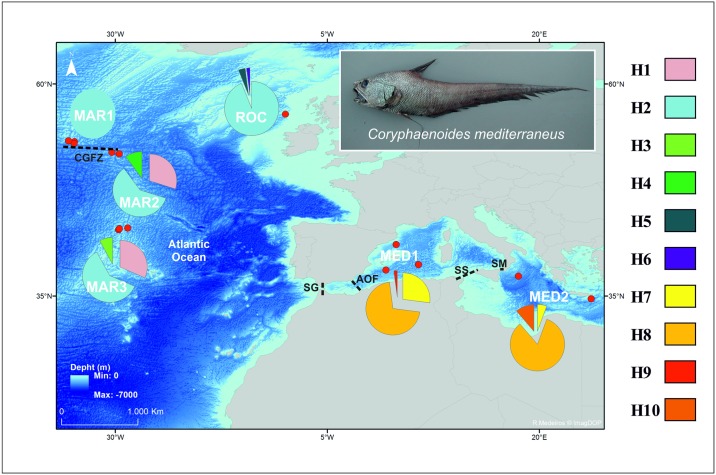
Map showing the sampling sites (red dots) of for Coryphaenoides mediterraneus.Pie charts report the haplotype distributions of the mtDNA COI, with the proportion of each haplotype within each collection site. Each haplotype is colour coded according to the legend on the right. Abbreviations of the collection sites are given in Table 1. Dark and dashed lines represent the potential barriers to gene flow: CGFZ—Charlie-Gibbs fraction zone; SG—Strait of Gibraltar; AOF- Almeria-Oran front; SS—Strait of Sicily; SM—Strait of Messina. Map under a CC BY license, with publish permission from R. Medeiros.